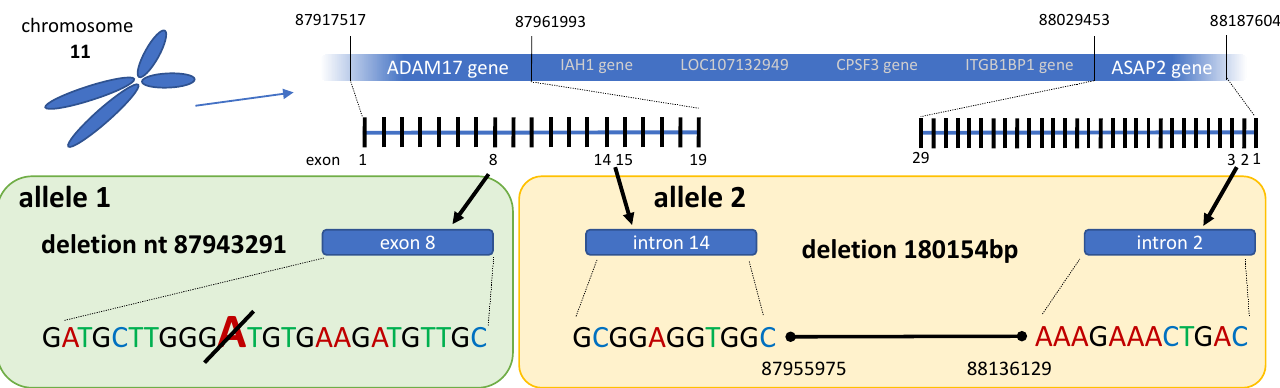
Figure 2. Genetic alterations of the ADAM17 gene in CRIB-1 cells. Nucleotide positions relative to the ARS-UCD1.2 reference bovine genome. Alignments of reads in the modified regions are shown in Supplementary Figure S1.